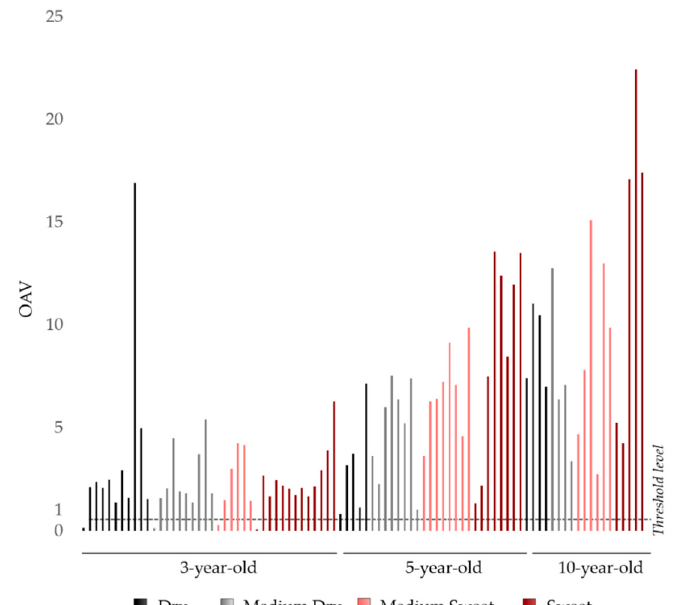
Figure 2. Odor activity values (OAVs) of sotolon determined in 3-, 5-, and 10-year-old MW blends.